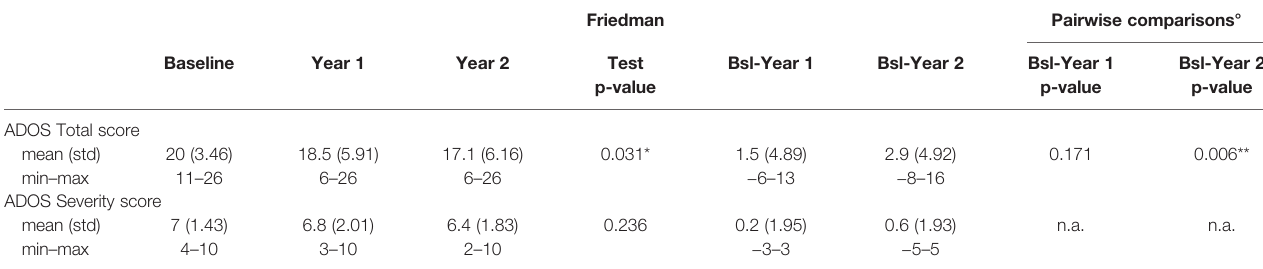
Table 3 ). The possible impact of age, total ADOS scores, and ADOS severity scores at baseline were estimated by comparing subgroups above and below the respective median values: no statistically signi fi cant or relevant subgroup differences were noted for any of these baseline variables (data not shown). TABLE 3 | Summary statistics for ADOS total and severity score by time point and change from baseline, and results of Friedman test and pairwise comparisons (N = 32). Friedman Pairwise